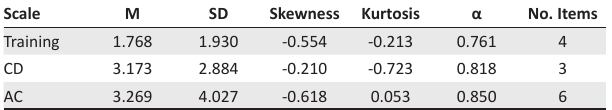
TABLE 1 : Descriptive statistics, reliability statistics.